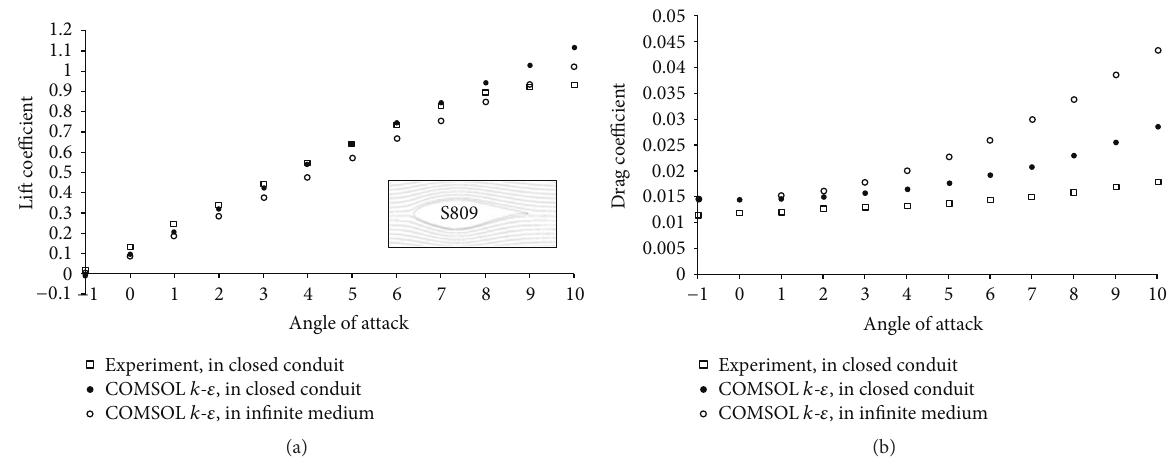
Figure 6: Comparison for validation of S809 airfoil of CFD computational results using COMSOL k - 𝜀 turbulence model and experimental values from Somers [50] at Re = 1 E 6; (a) lift coefficient; (b) drag coefficient.